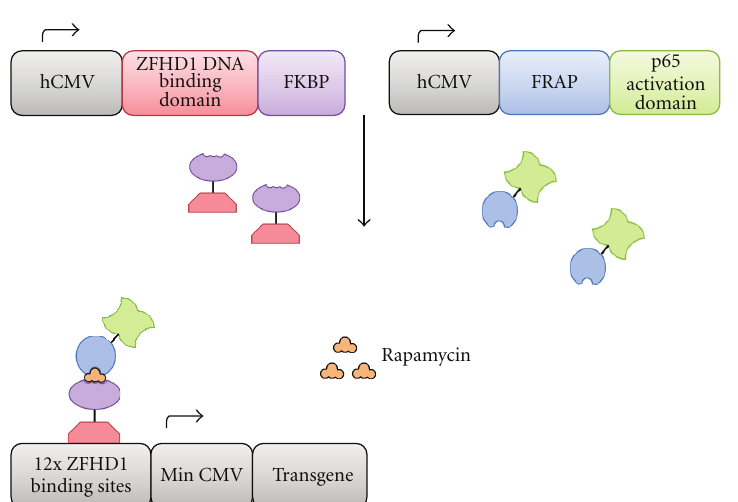
Figure 3: Schematic of the rapamycin regulation system. The constitutively active human cytomegalovirus (hCMV) promoter drives expression of two fusion transcription factors. (Top left) A transcription factor consisting of three copies of the FKBP protein fused to a ZFHD1 DNA binding domain. (Top right) A transcription factor consisting of a FRAP protein with a p65 activation domain. Rapamycin enables dimerization of the transcription factors, with enable binding to 12xZFHD1 binding sites and activation, respectively, driving expression of a transgene upstream of a minimal CMV promoter. ZFHD1: zinc finger homeodomain-1; FKBP: FK-binding protein; FRAP: FKBP-rapamycin associated protein